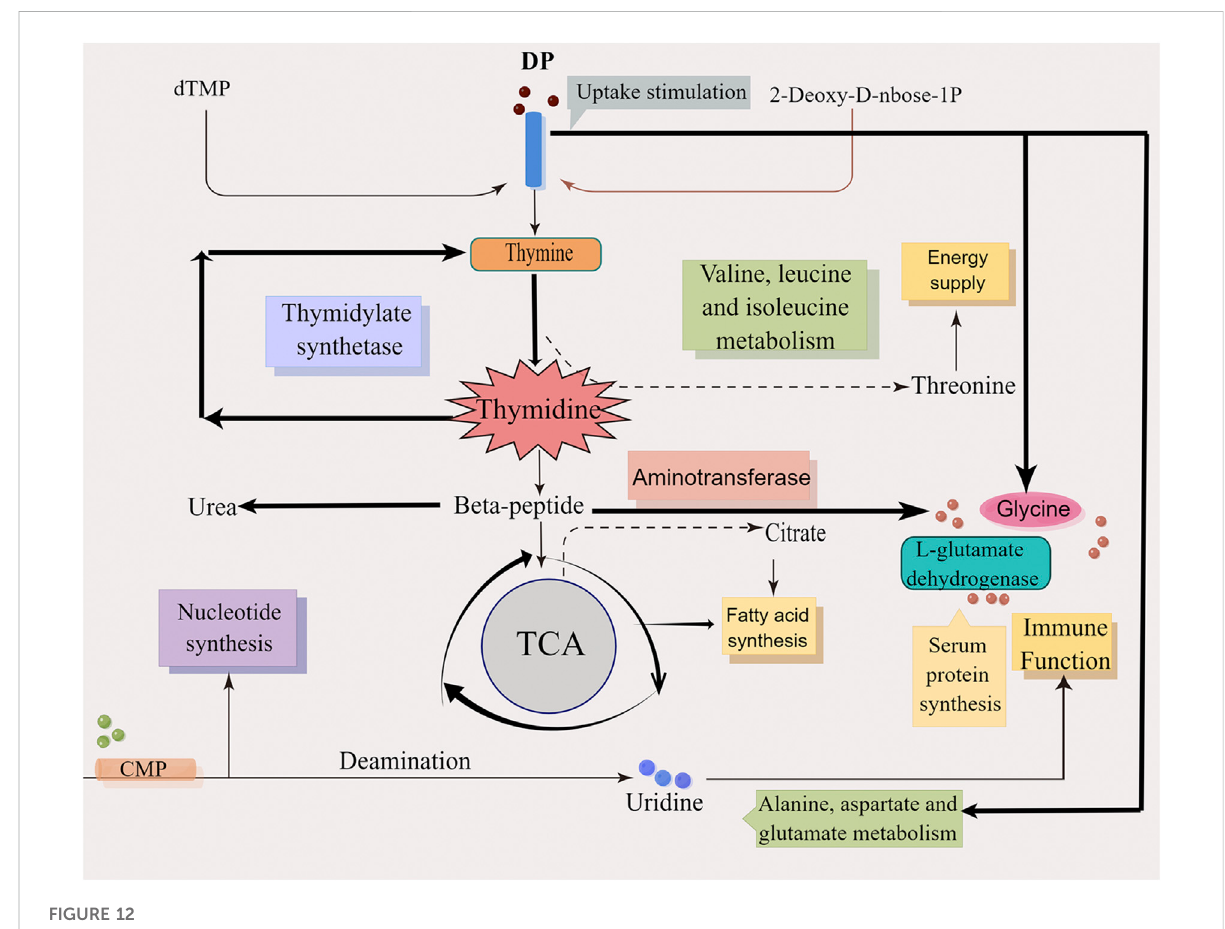
FIGURE 12 The mechanism diagram of DP in treating DFU